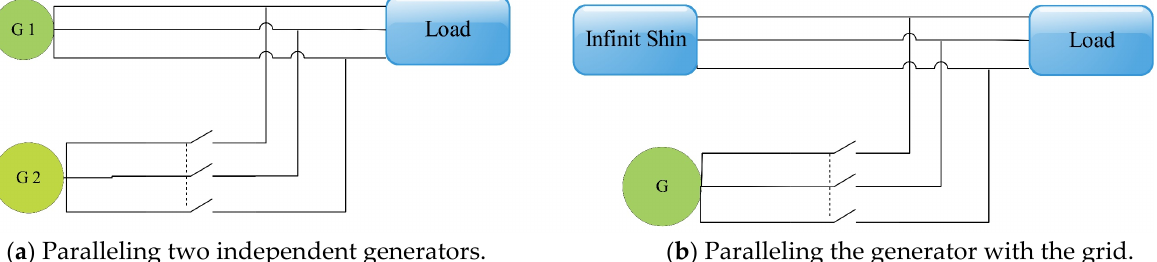
Figure 9. The proposed method for fast charging. ( a ) Paralleling two independent generators. ( b ) Paralleling the generator with the grid.